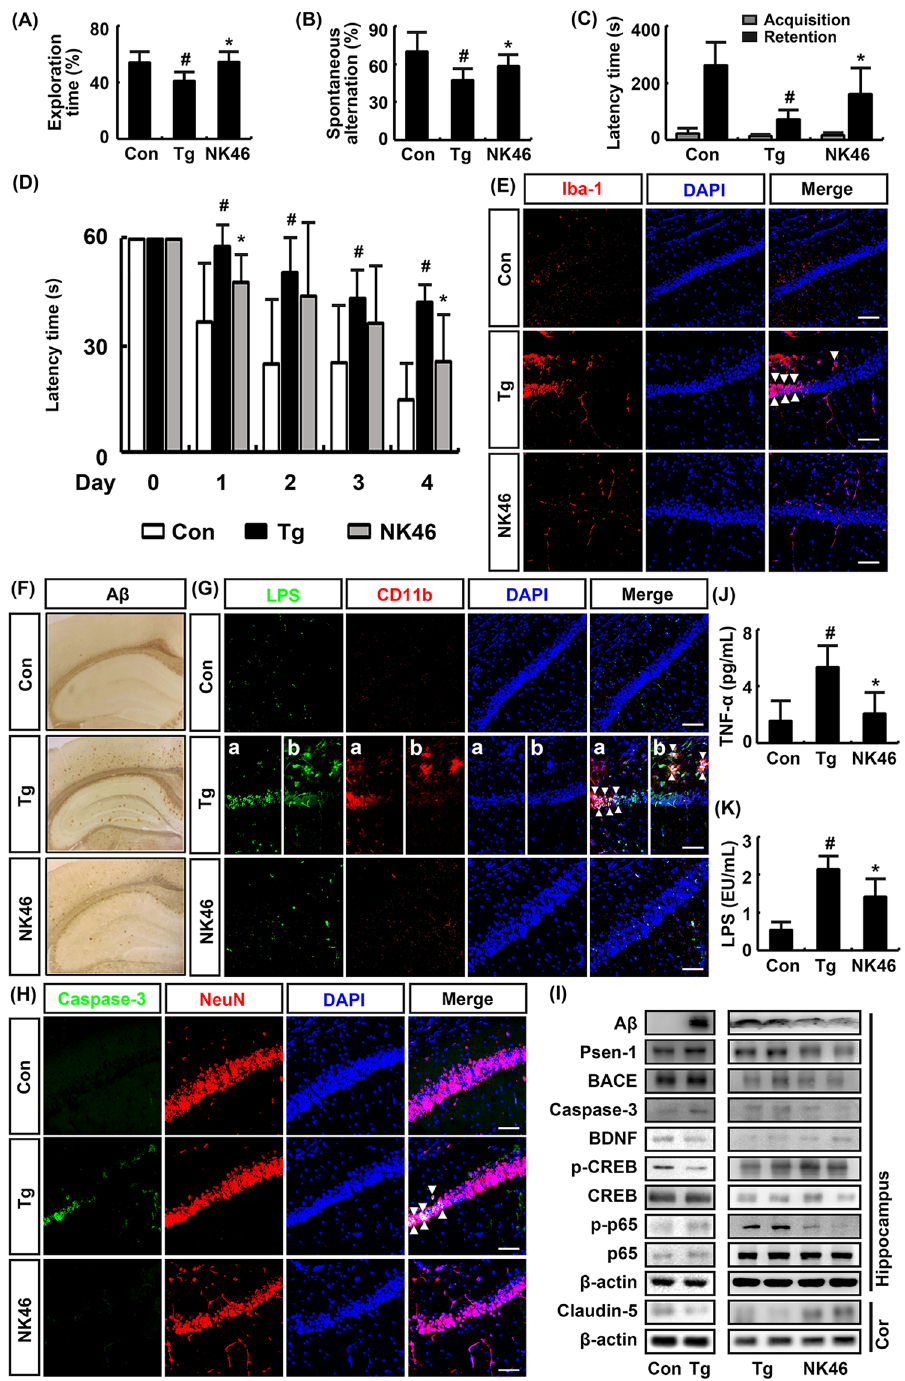
Figure 3. NK46 attenuated cognitive decline in 5XFAD-Tg mice. Effects on exploration time in novel object recognition task ( A ), spontaneous alteration in Y-maze task ( B ), latency time in passive avoidance task ( C ), and latency time in the Morris water maze tasks ( D ). ( E ) Effects on Iba1 + (activated microglia) population in the hippocampus, assessed by a confocal microscope. ( F ) Effect on the A β expression in the brain. ( G ) Effect on LPS + /CD11b + in the pyramidal (a) and stratum oriens regions (b) of hippocampus. ( H ) Effect on caspase-3 + / Neu + (apoptotic neuron cell) populations. Bar indicates 0.1 mm. ( I ) Effect on BDNF, BACE1, Psen1, caspase-3, and claudin-5 expression, NF- κ B and CREB activation, assessed by immunoblotting. Effect on TNF- α ( J ) and LPS levels ( K ) in the blood, assessed by ELISA. Test agent (Tg, vehicle alone; NK46, 1 × 10 9 CFU/mouse/day) was orally administered for 2 months in Tg mice. Control mice (Con) were treated with vehicle alone. All data were expressed as mean ± SD (n = 6). # p < 0.05 vs. Con group. * p < 0.05 vs . Tg